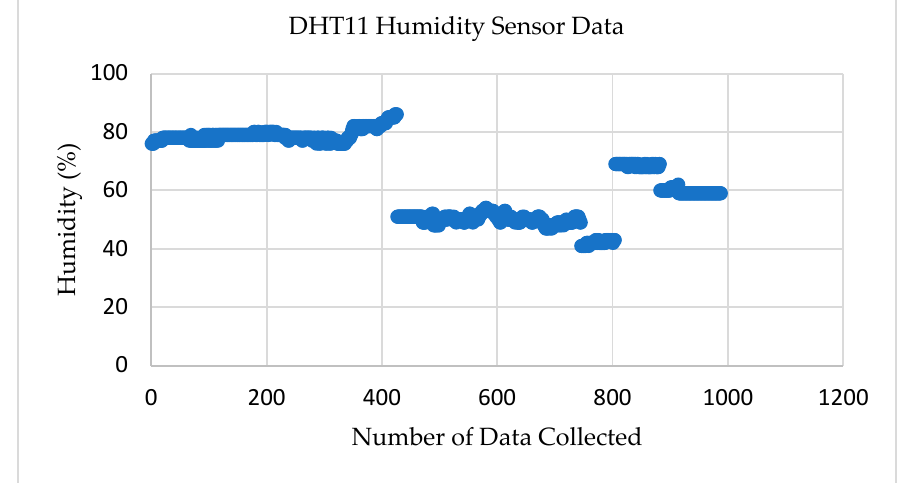
Figure 9. Test results for the DHT11 humidity Sensor.